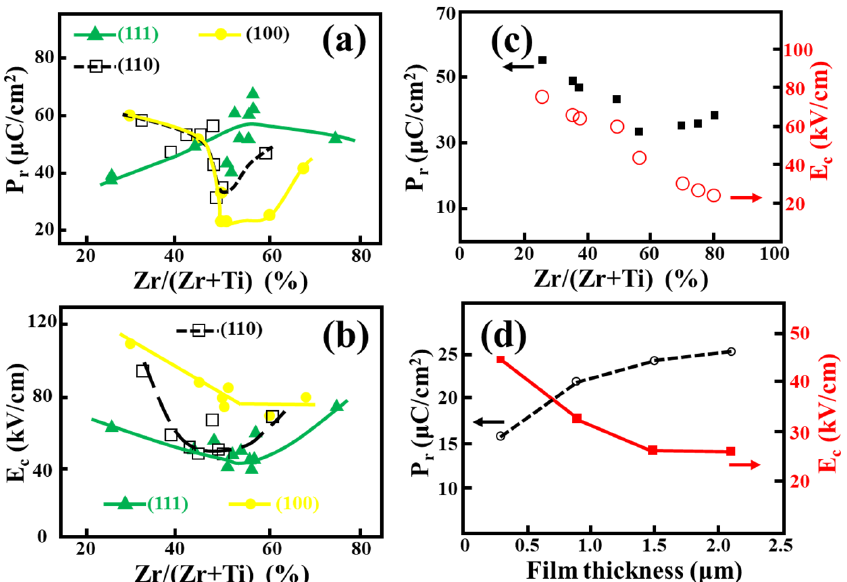
Figure 10. ( a ) Variation of P r as a function of composition (Zr/Ti ratio) and orientation. Reprinted with permission from [81] Copyright 2004 AIP Publishing; ( b ) composition and orientation dependences of E c for PZT thin films. Reprinted with permission from [81] Copyright 2004 AIP Publishing; ( c ) composition variations of P r and E c values for PZT thin films. Reprinted with permission from [83] Copyright 1997 AIP Publishing; ( d ) thickness dependence of ferroelectric properties of PZT thin films. Reprinted with permission from [35] Copyright 1999 Elsevier.